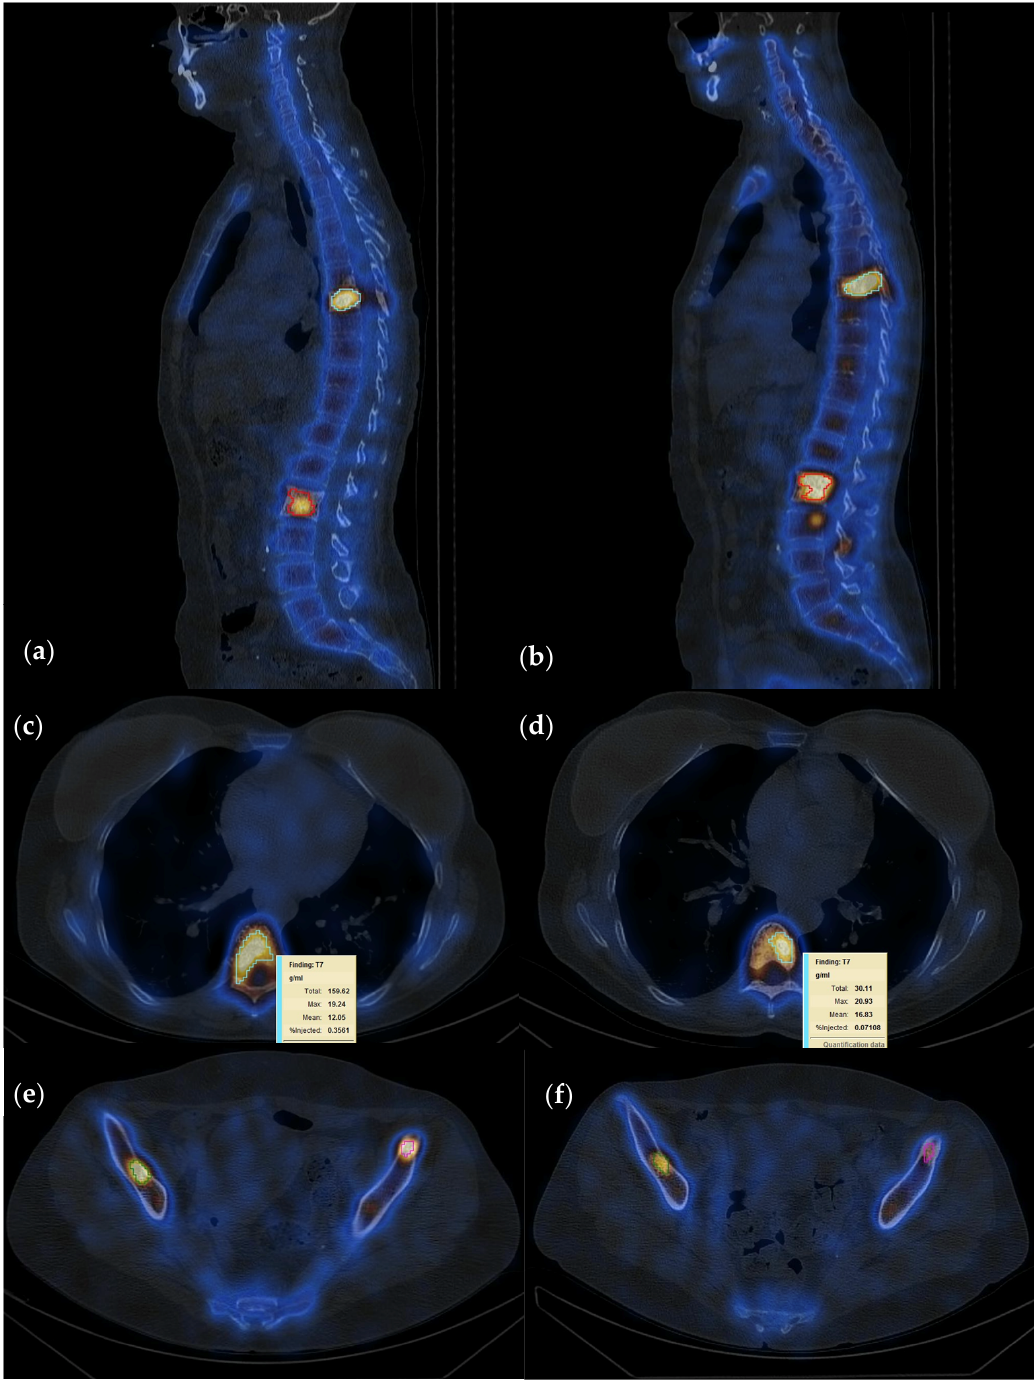
Figure 2. Fifty-five-year-old female patient with invasive lobular carcinoma operated in 2008 (left mastectomy) treated with chemotherapy, radiotherapy and hormone therapy; local recurrence and bone metastasis diagnosed in October 2021; multiple metastatic lesions with high uptake localized at T7, L2, and both iliac spines currently in treatment with osteoclast inhibitors; ( a – c ) baseline study; ( d – f ) follow-up study after 6 months of osteoclast inhibitor; quantification showed a summed SUVmax 81.3 g/mL on the baseline and 47.2 g/mL on the follow-up study, suggesting PR with a decrease in radiotracer uptake of 58%.